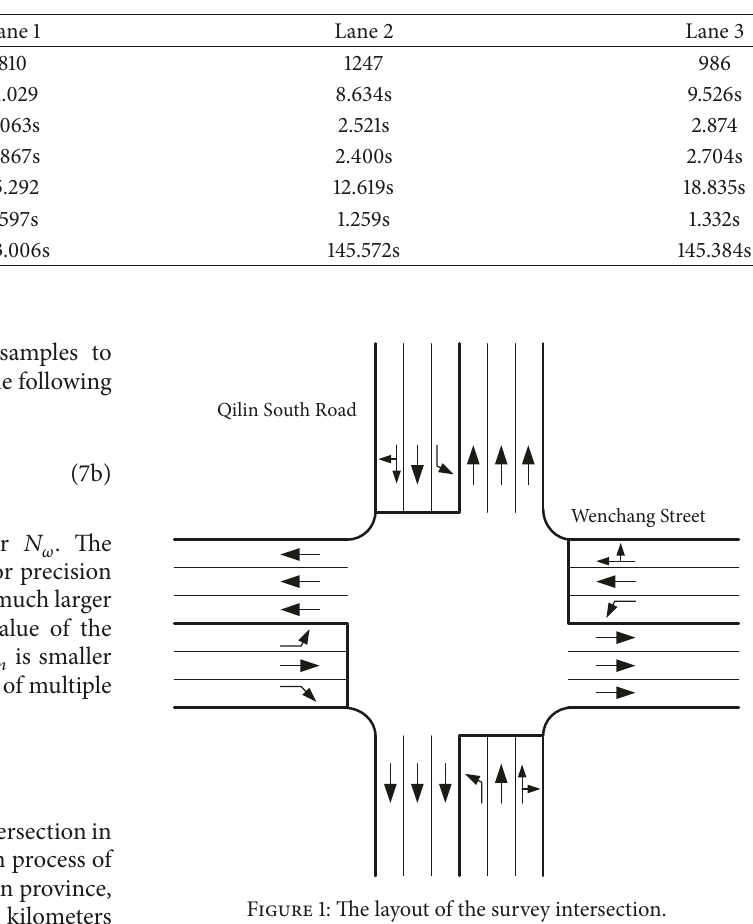
Table 2: Statistics of the raw time headways.